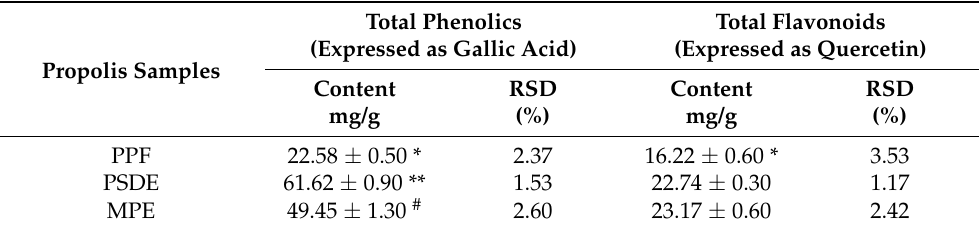
Table 2. Total phenolic and flavonoid compound determination of the three propolis formulations investigated using spectrophotometric methods normalized to the same dry matter concentration (40% propolis dry matter). See Table 1 for definitions of the propolis formulation abbreviations. Total Phenolics Total Flavonoids (Expressed as Gallic Acid) (Expressed as Quercetin) Propolis Samples Content